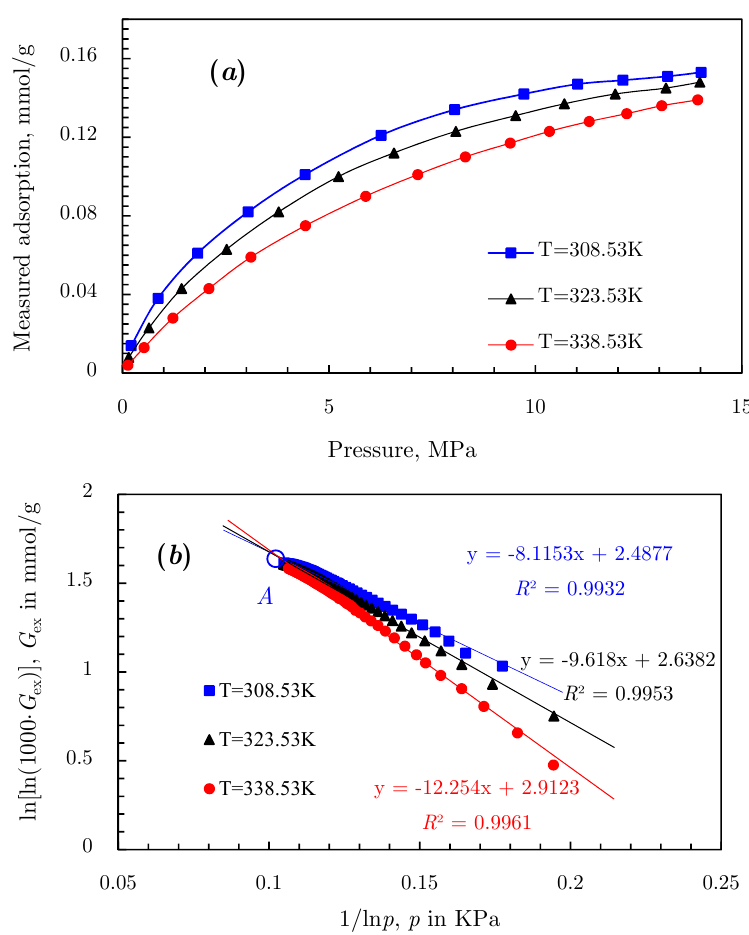
Figure 22. The sorption experimental data of Woodford shale ( a ) [78] as well as their linearized isotherms ( b ).